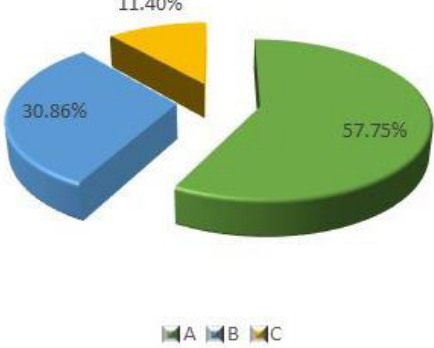
Figure 4. Class distribution of IP